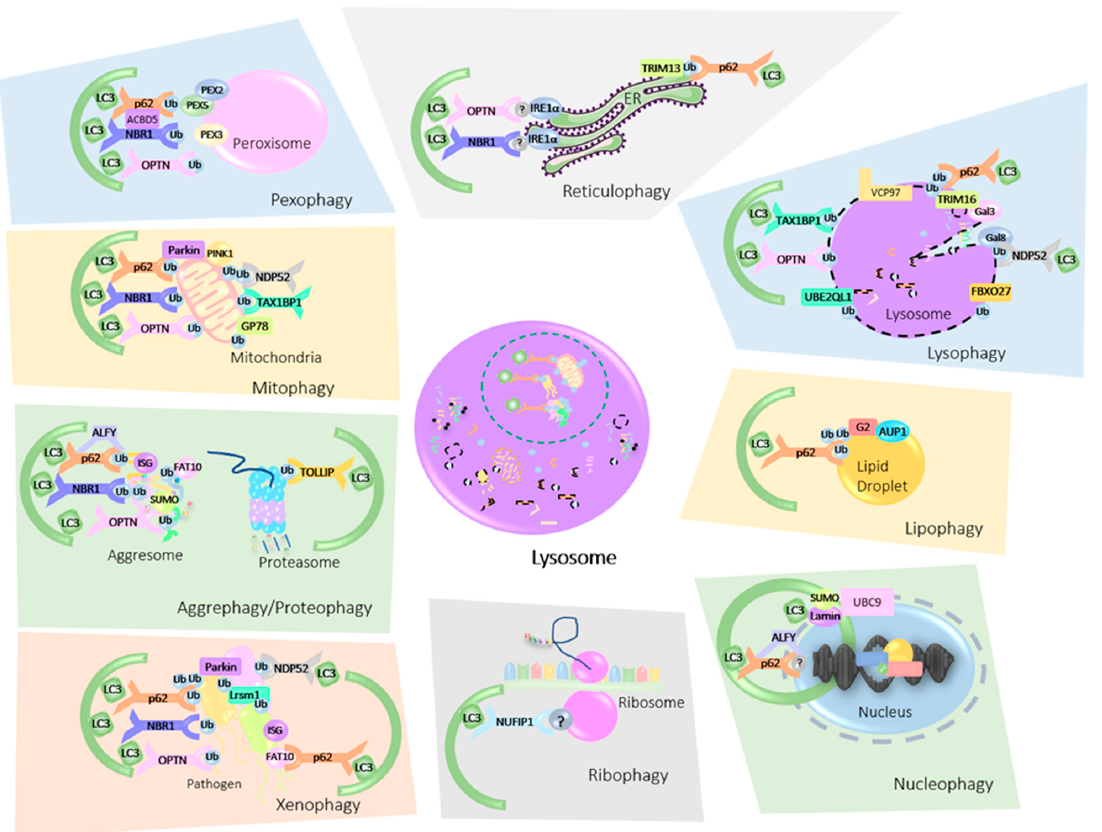
Figure 2. Mammalian Ub-mediated Organellophagy. Damaged, dysfunctional or otherwise superfluous organelles are tagged for degradation by ubiquitin (Ub) or ubiquitin-like molecular modifiers (SUMO, FAT10, ISG15). These post translational modifications (PTMs) are then recognized by autophagy cargo receptors (p62, NBR1, OPTN, NDP52, TAX1BP1, NUFIP1) which bind both the ubiquitinated cargo and the microtubule-associated protein 1B light chain 3B (LC3B). The autophagosome engulfs the receptor cargo complex and delivers it to the lysosome for breakdown. ER-Phagy / Reticulophagy : ER stress sensor IRE1 α , is activated upon ER stress. IRE1 α interacts with p62, OPTN, and NBR1 to promote reticulophagy, but whether Ub is involved in this process is unclear. Self-ubiquitination of the E3 ligase TRIM13 also recruits p62 to damaged ER. This results in the sequestration of the ER within autophagosomes and its delivery to the lysosome for elimination. Pexophagy : PEX2 ubiquitinates the peroxisomal import receptor PEX5 which is then recognized by autophagy receptors p62 and NBR1. PEX3 is also involved in this process and enhances peroxisomal ubiquitination, while peroxisomal acyl-CoA binding domain containing 5 (ACBD5) regulates the pexophagy receptor protein complex. OPTN was also shown to be involved in this process. Mitophagy : Mitochondrial damage results in the stabilization of PINK1 on the mitochondrial outer membrane, which entices the arrival of E3 ligases Parkin and GP78. These ligases, in turn, ubiquitinate a variety of substrates on the mitochondrial membrane which recruits autophagy receptors p62, NDP52, OPTN, NBR1, and TAX1BP1. Aggrephagy / Proteophagy: Protein aggregates